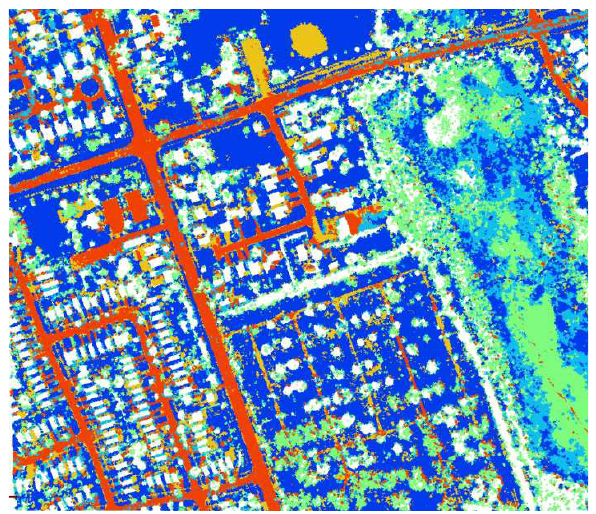
Figure 7. Channel pattern sub classification of the geometrically derived ground class. red = ‘darker asphalt’ and ‘lighter asphalt’, yellow= ‘sand / bare soil’, light green = ‘wetlands’, light blue = ‘dried up grass’, dark blue = ‘green grass’